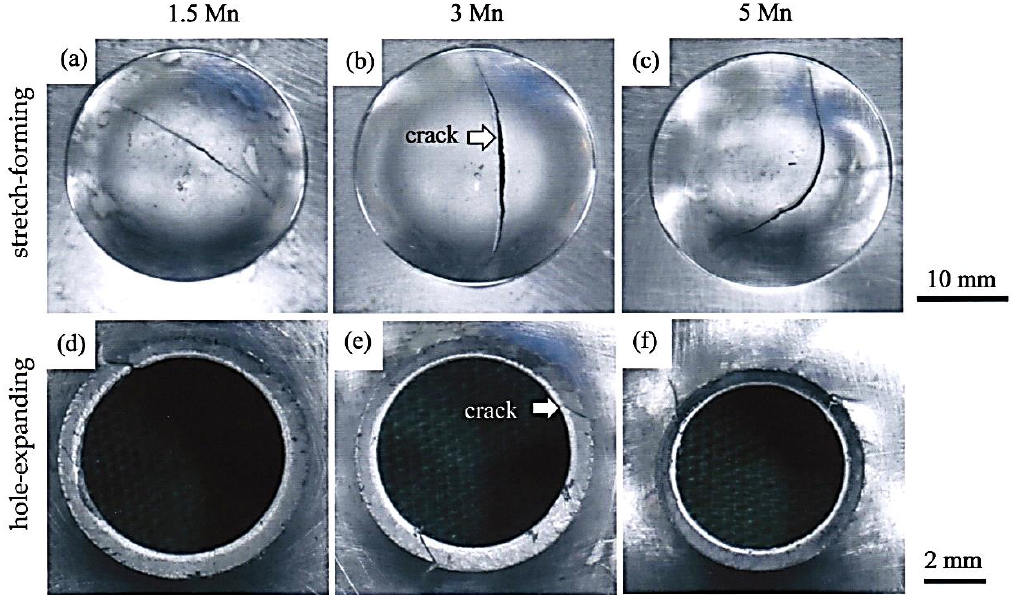
Figure 8. Typical samples of the 1.5Mn, 3Mn, and 5Mn steels respectively subjected to the IT process at 370 ◦ C, 280 ◦ C, and 180 ◦ C after stretch-forming ( a − c ) and hole-expanding tests ( d − f ). The IT temperatures are corresponding to M f + (30 ◦ C to 70 ◦ C).